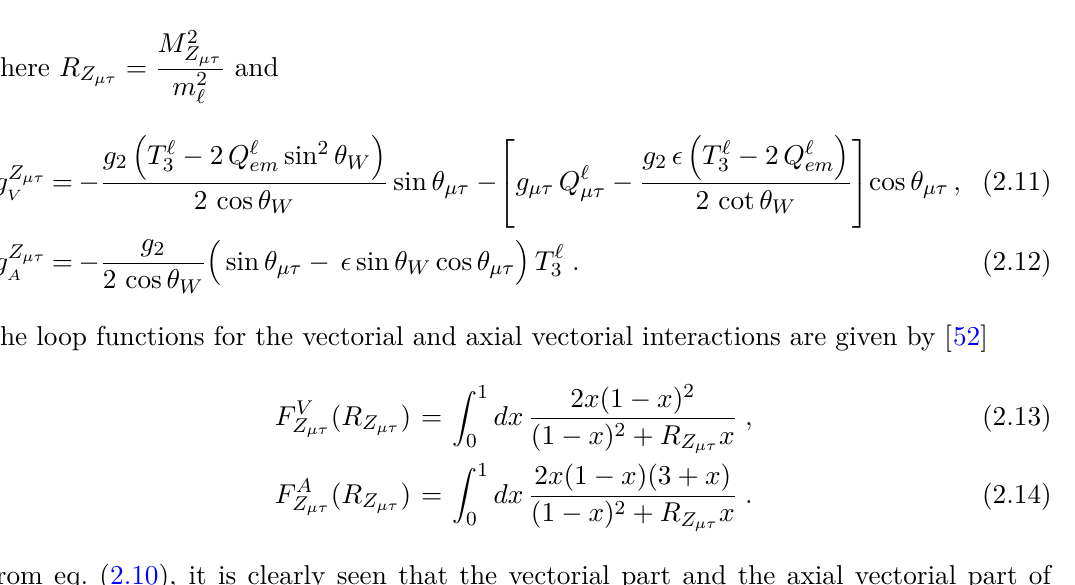
Figure 1 . Feynman diagrams for one loop contributions in the anomalous magnetic moments of muon and